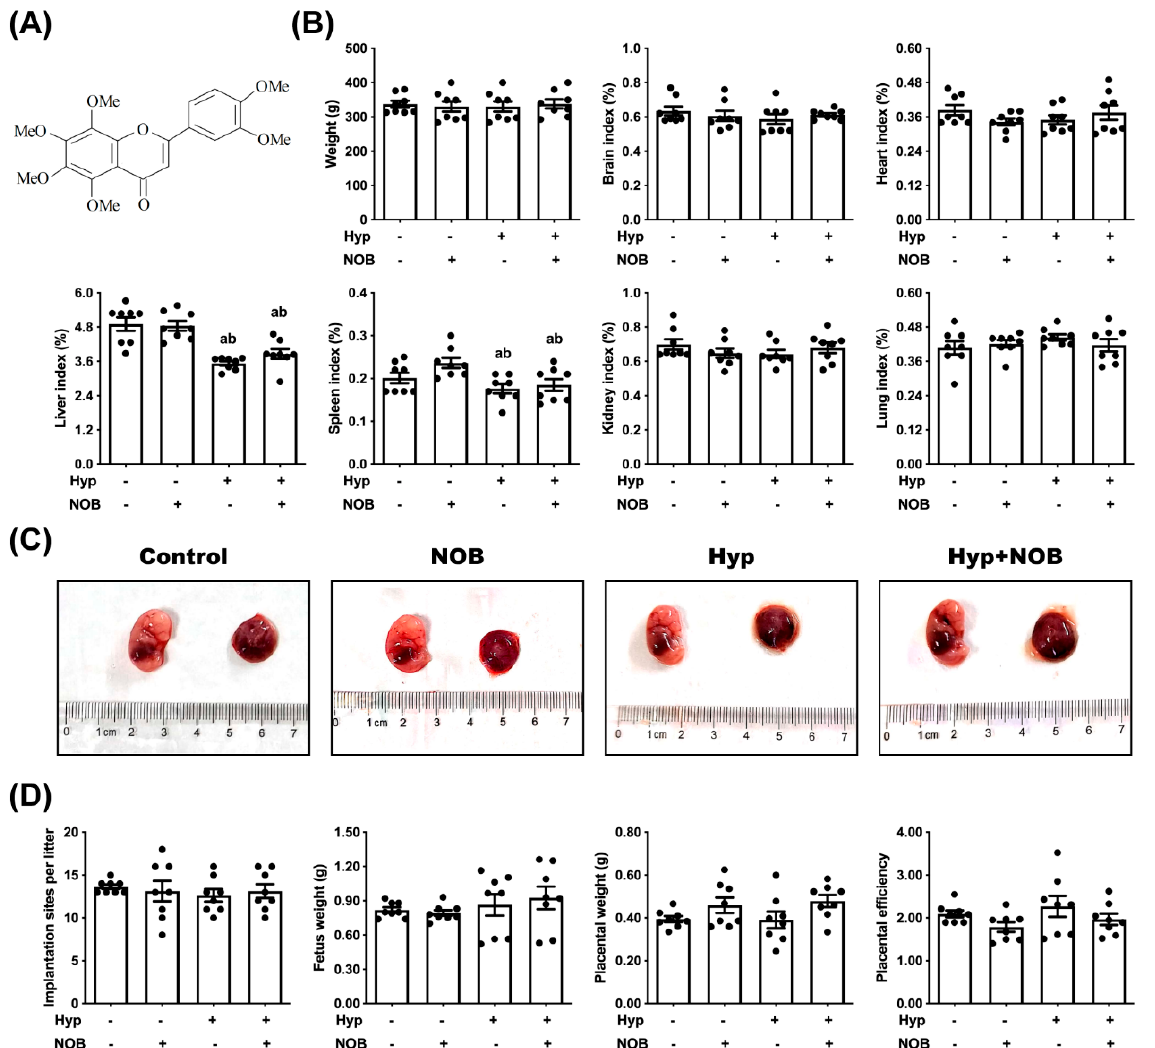
Figure 1. The influence of NOB intervention during pregnancy on the weight of the maternal rats, placenta, and fetus in RUPP-induced SD rats. ( A ) Chemical structure of Nobiletin (5,6,7,8,3,4 -hex- amethoxyflavone, NOB). ( B ) Body weight and organ coefficient of the pregnant rats. ( C ) Representa- tive pictures of the placenta and fetus. ( D ) The implantation sites per litter, placental weight, fetus weight, and placental efficiency (fetal/placental weight ratio). Data are expressed as the mean ± standard error (Mean ± SEM). a: comparing with the control groups, p < 0.05; b: comparing with the NOB groups, p < 0.05.